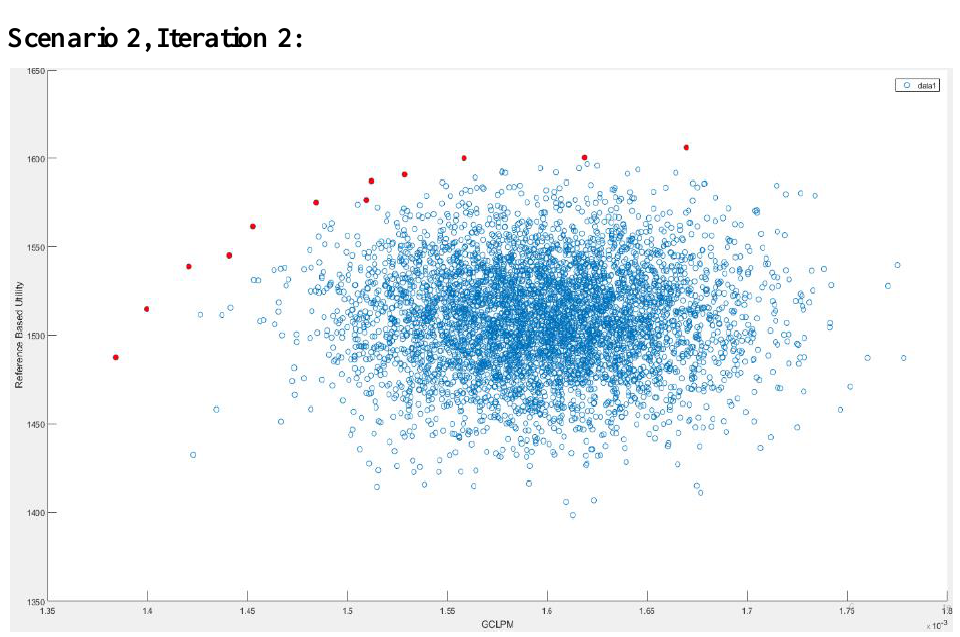
Figure 7. The Result Of Investigation Of 5,000 Different Portfolios In Second Iteration Of Scenario 2